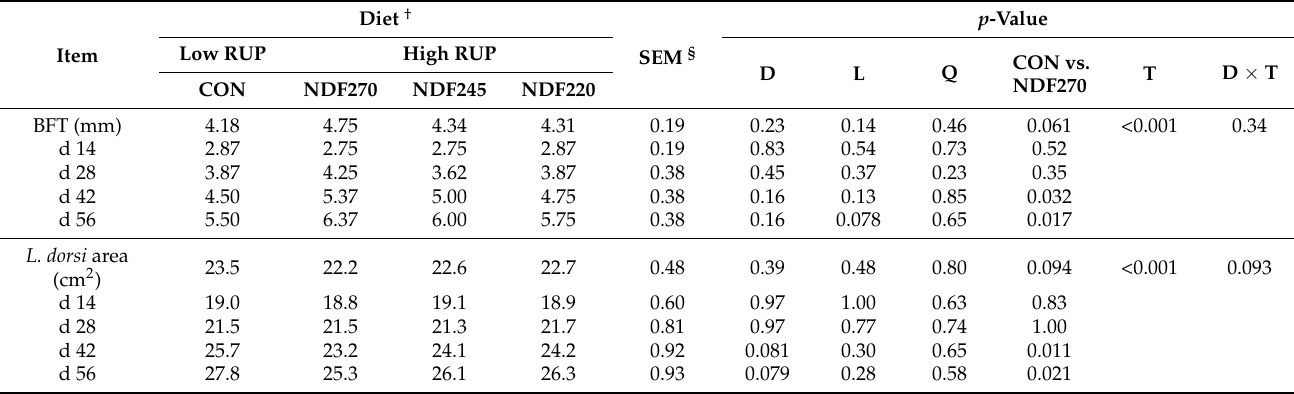
Table 6. Ultrasound measurements of Longissimus dorsi muscle area and subcutaneous backfat thickness (BFT) in lambs fed different levels of dietary neutral detergent fiber (NDF) and rumen undegradable protein